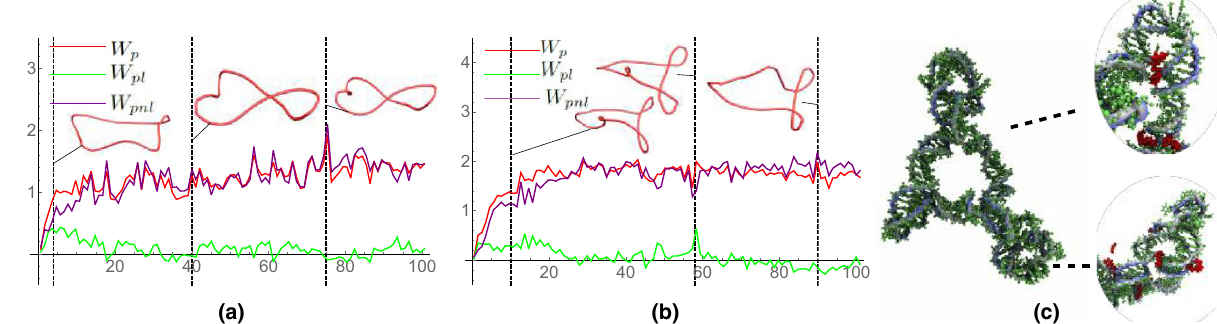
Figure 9. Polar writhe calculations for two DNA minicirlce cases. ( a ) indicates the writhing evolution of a 108 base pair Lk = 14 minicircle with a (GG) 27 (GC) 27 (GG) 27 (GC) 27 sequence exposed to a 10 mM spermine cosolute concentration. ( b ) indicates the writhing evolution of a 108 base pair Lk = 14 minicircle with an (AA) 27 (AT) 27 (AA) 27 (AT) 27 sequence exposed to a 10mM spermine cosolute concentration. ( c ) depicts spermine bridging in an (AA) 27 (AT) 27 (AA) 27 (AT) 27 minicircle. Spermine molecules are shown in red. Spikes in W pnl in ( a ) indicate the formation of plectonemic loops within the DNA loops/buckling points within the minicircle structures caused by spermine bridging. Spermine molecules adsorb to the backbone of the DNA minicircles early in the trajectories and gradually bridge together adjacent tracts of